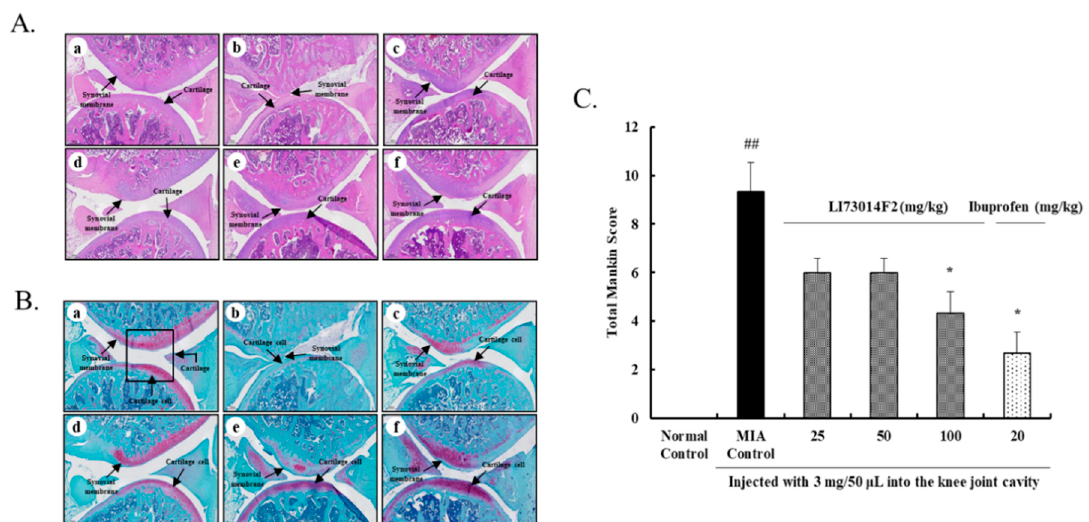
Figure 4. Effects of LI73014F2 on the histological evaluation of joint activity in MIA-induced osteoarthritis in rats. ( A ) Cartilage and synovial membrane in knee joints were stained with hematoxylin and eosin (H&E), ( B ) cartilage cell and proteoglycan layer in knee joints stained with Safranin O, and ( C ) graded on a 0–13 scale using the Mankin scoring system. (a) Normal Control group, (b) MIA Control group, (c) MIA + LI73014F2 25 mg/kg, (d) MIA + LI73014F2 50 mg/kg, (e) MIA + LI73014F2 100 mg/kg, and (f) MIA + ibuprofen 20 mg/kg. Data are expressed as mean ± SEM ( n = 5/group). * p < 0.05, compared to the MIA-induced control group; ## p < 0.01, compared to the non-MIA-induced control group.